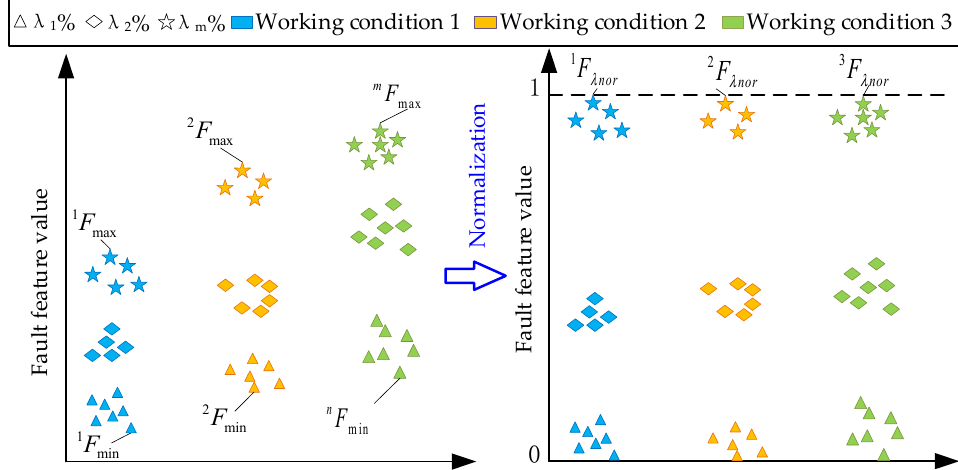
Figure 6. The schematic diagram of MSN.